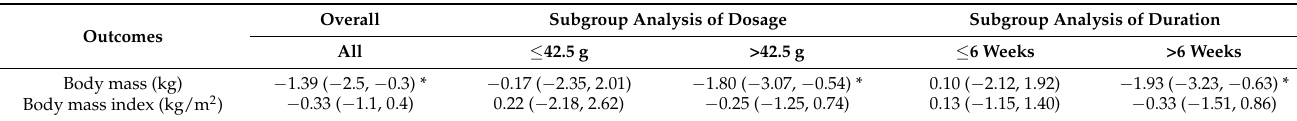
Table 2. Stratified mean body mass ( n = 11) and body mass index ( n = 6) changes by almond dosage and trial duration (* p < 0.05)